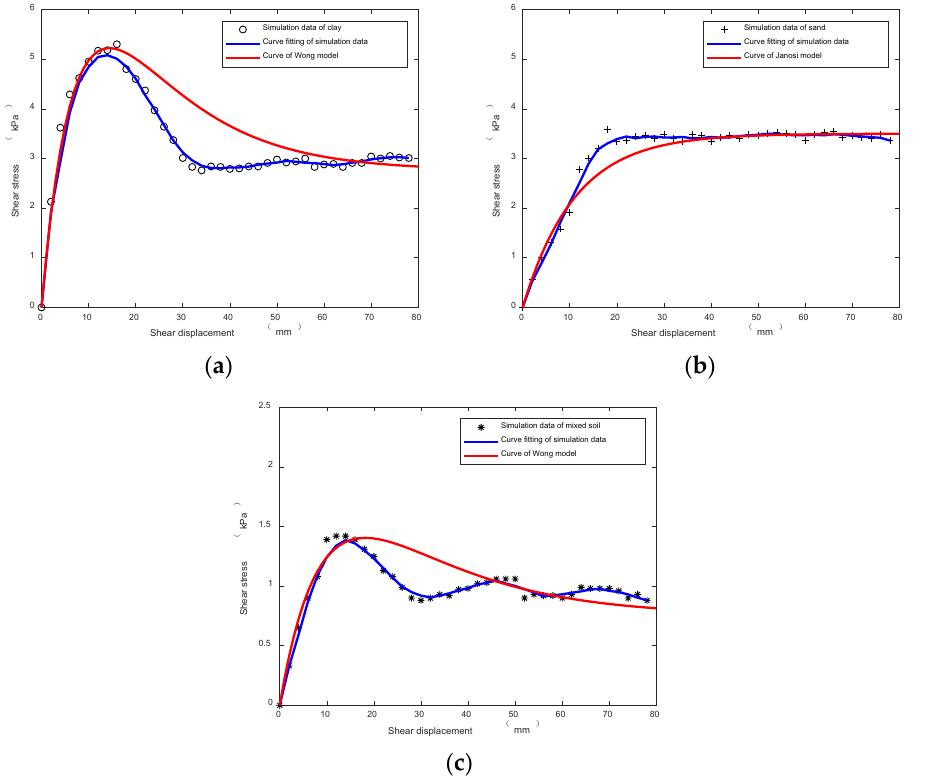
Figure 20. Curve of simulation data and classic model. ( a ) Curve fitting of clay. ( b ) Curve fitting of sand. ( c ) Curve fitting of mixed soil 2#.